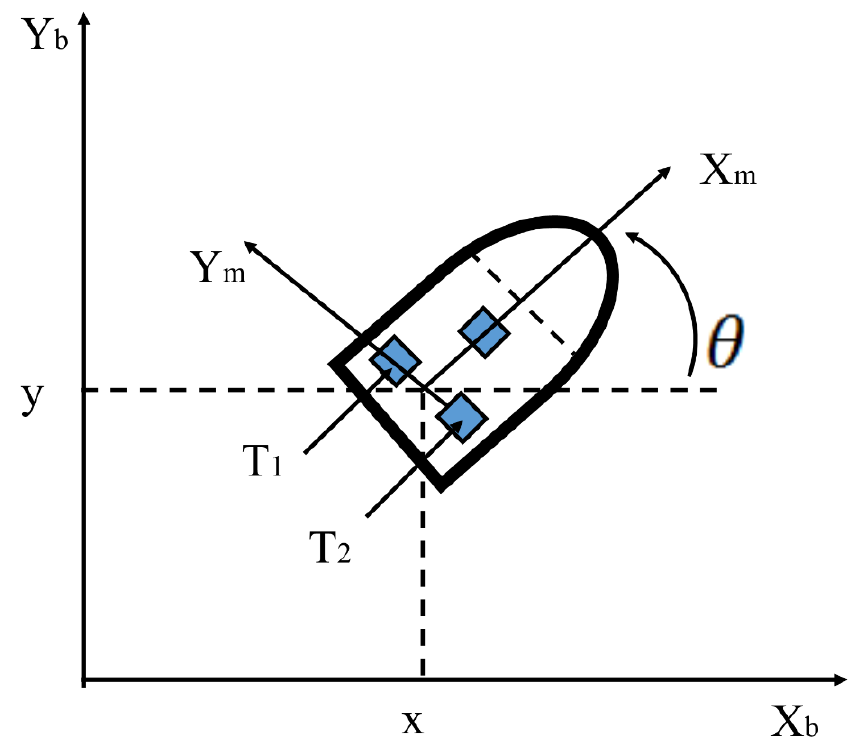
Figure 2. Surface of the GT2FS.